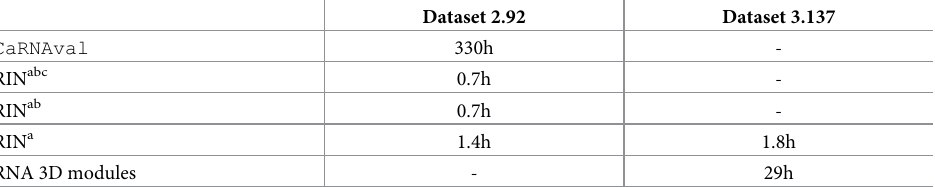
Table 5. Runtimes over 20 CPUs. This table displays the runtime of previous method ( CaRNAval ) and our method (others rows) for different classes of structures extracted. The values have been measured with the linux time command and are real CPU times i.e. clock time elapsed between the start and the end of the execution. All runs have been per- formed on the same